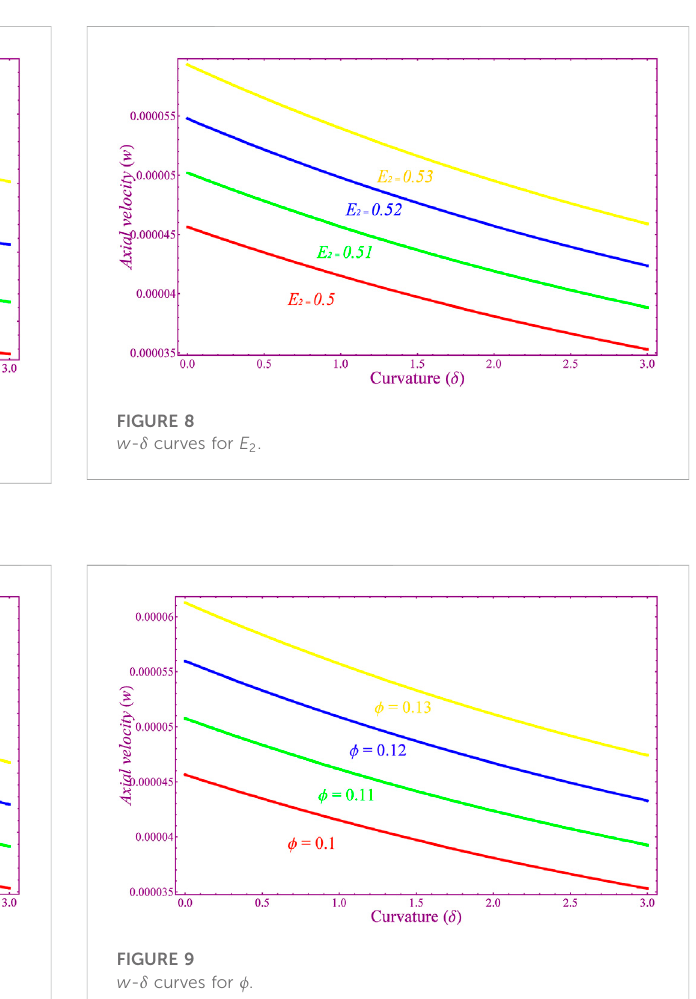
FIGURE 9 w - δ curves for ϕ